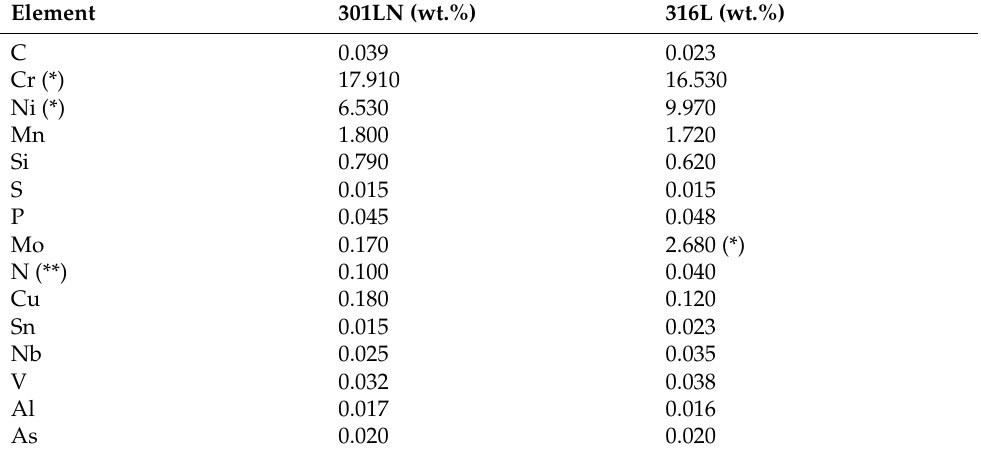
Table 1. Nominal chemical composition of the studied stainless-steel